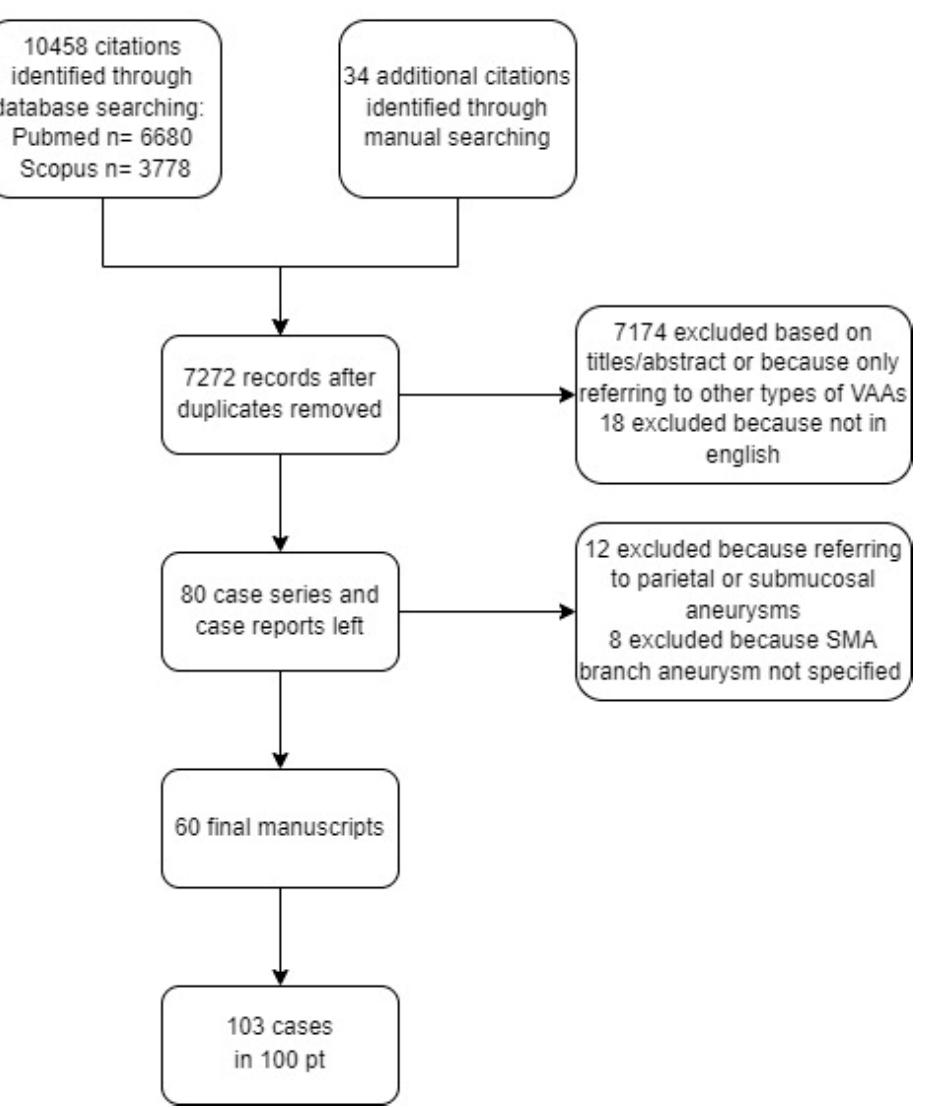
Figure 4. The flow chart outlining the strategy identifying eligible case studies. Data extracted were number of cases reported, patient demographics, aneurysm location (jejunal vs. ileal), type (true vs. false), size, etiology, clinical presentation, presence of concomitant aneurysms, management and treatment, mortality including aneurysm- related